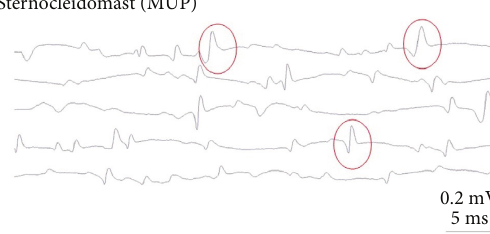
Figure 4: Electromyogram on day 28 postadministration of 4IU botulinum toxin. Findings of SEA are circled in